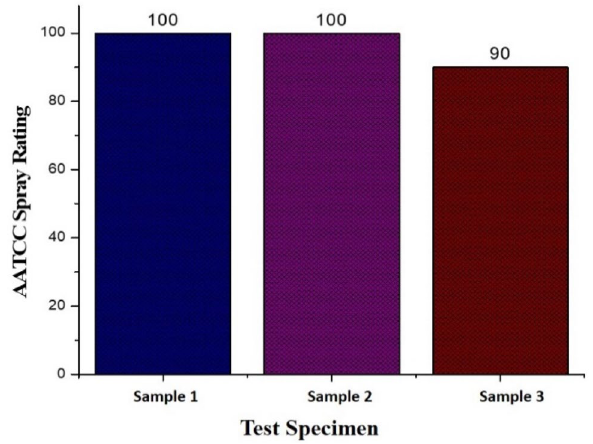
Fig. 18 AATCC 35-2013 water repellency rain test of HDTMS-treated nonwoven cotton